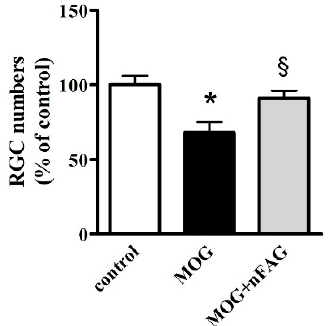
Figure 6. nFAG dietary supplementation prevents RGC loss. Counting of RGCs immunolabeled with Brn3a antibody refers to the whole mounts shown in Figure 5. * p < 0.01 versus control. § p < 0.05 versus MOG (one-way ANOVA followed by the Newman-Keuls multiple comparison post-hoc test). White bars, control mice; black bars, MOG-treated mice; grey bars, MOG-treated mice with nFAG dietary supplementation.